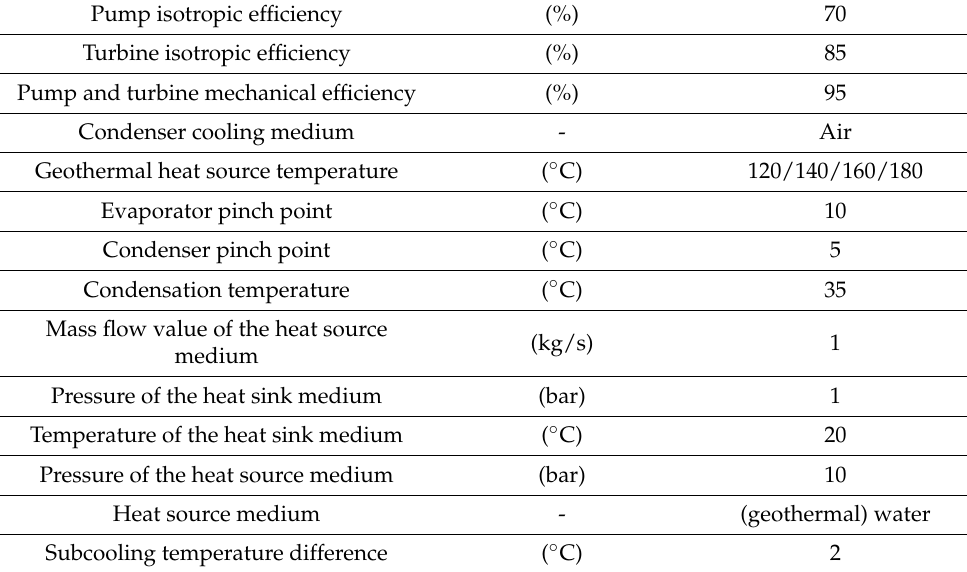
Table 2. Model parameters used in the simulations for all